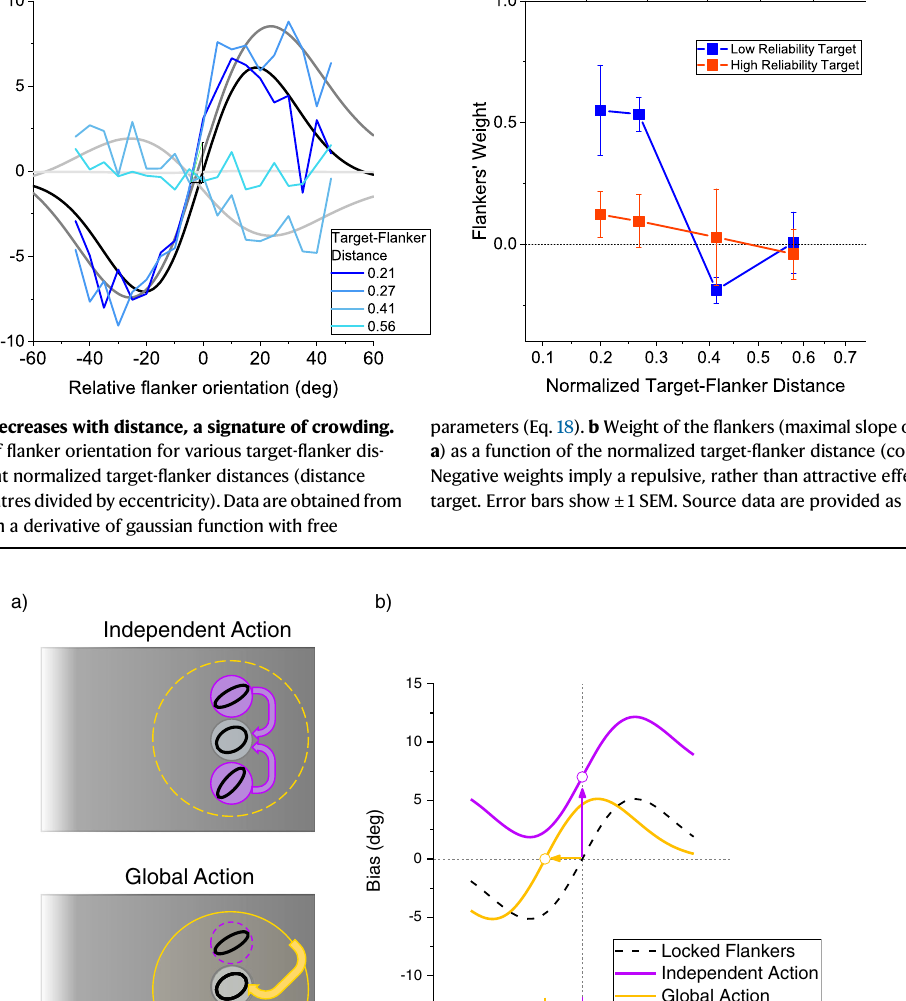
vary, the pattern should be similar to that of the main experiment (centre close to 0°),butraisedbecauseoftheactionofthelocked fl anker(purplecurve).If fl ankers are fi rst integrated at a more global stage, maximal effect is expected when all the elements in the larger operator average 0°. Since one of the fl ankers is locked at +15°, this occurs when the other fl anker is − 15°, leading to a leftward shift of the curve of the main experiment (yellow curve).